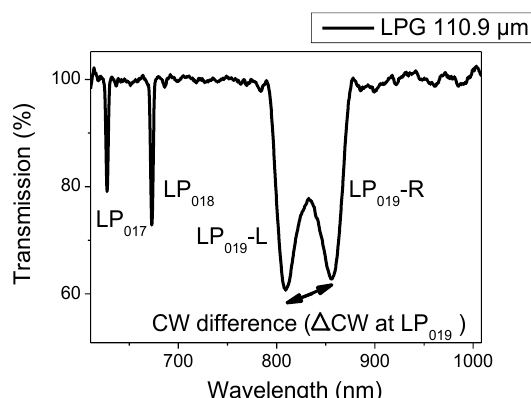
Figure 4. Transmission spectrum of an uncoated LPG with period of 110.9 µm measured in air, with attenuation bands at 670 nm, 800 and 850 nm corresponding to the LP 018 and LP 019 cladding modes respectively (the dual resonance was observed for the LP 019 cladding mode denoted as LP 019 -L (800 nm) and LP 019 -R (850 nm)); CW, central wavelength.